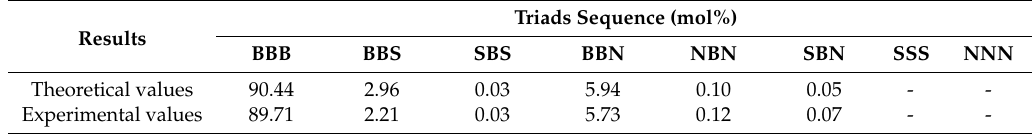
Table 5. The experimental and theoretical values for the di ff erent sequence